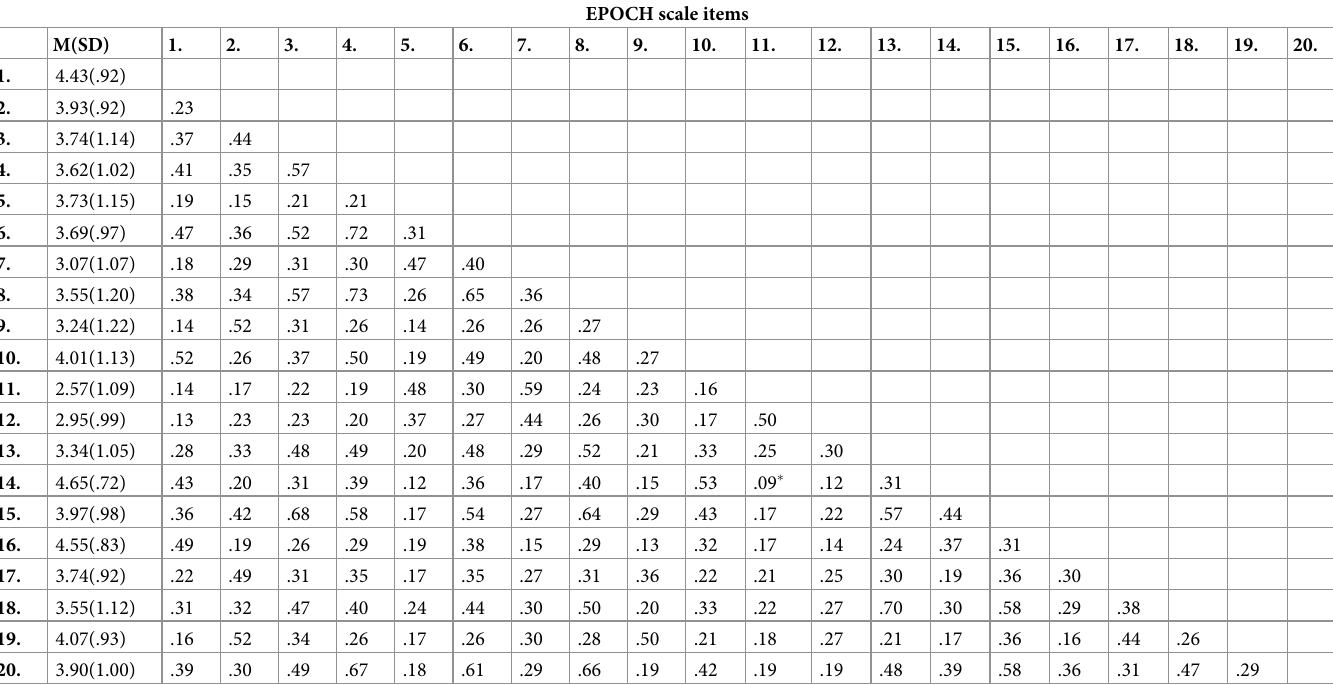
negative correlations with the DASS-21 subscales, and moderate to strong positive correlations with the CSE subscales. Optimism, by contrast, had a strong positive correlation with the CSE ( r = 0.66) and a strong negative correlation with the DASS-21 ( r = -0.56). Optimism also had moderate to strong negative correlations with the DASS-21 subscales, and a strong positive Table 3. EPOCH scale item intercorrelations and item descriptives ( N = 846).